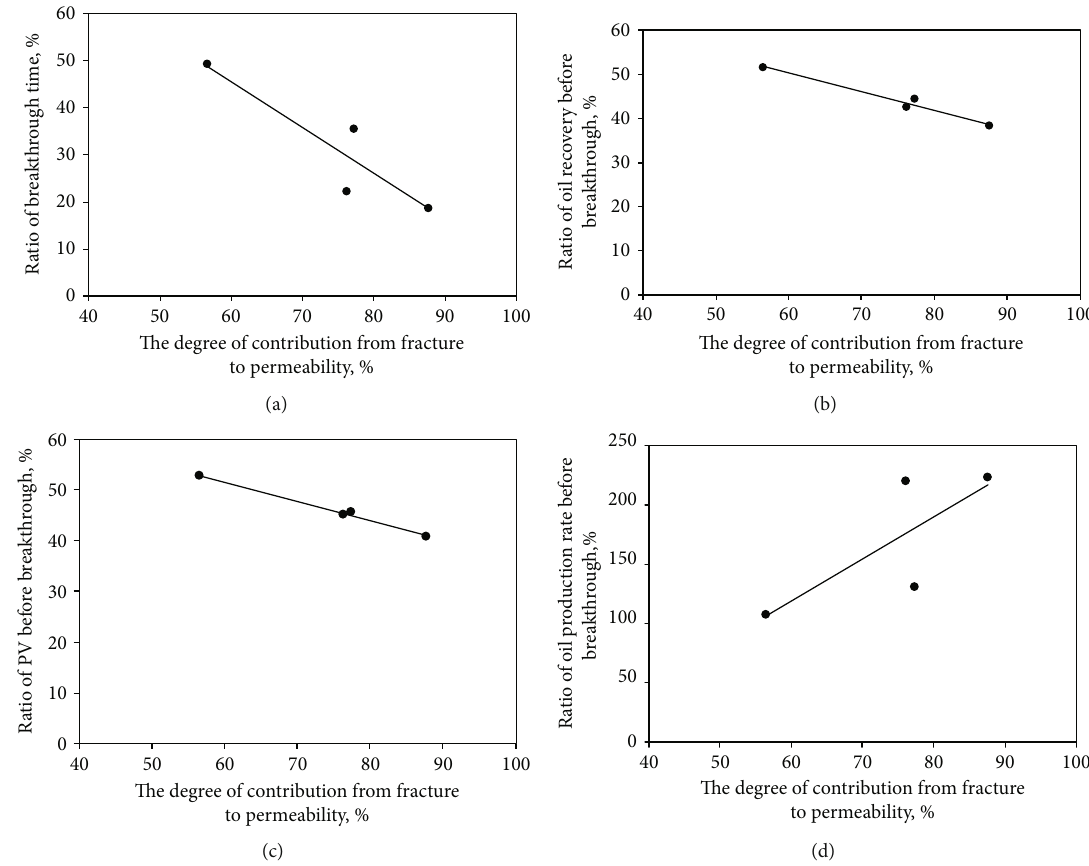
Figure 10: Contribution of fracture to permeability and the indices of displacement in water-free production stage. (a) Ratio of breakthrough times. (b) Oil recovery. (c) PV. (d) Oil production rate. Table 3: Displacement index under di ff erent displacing